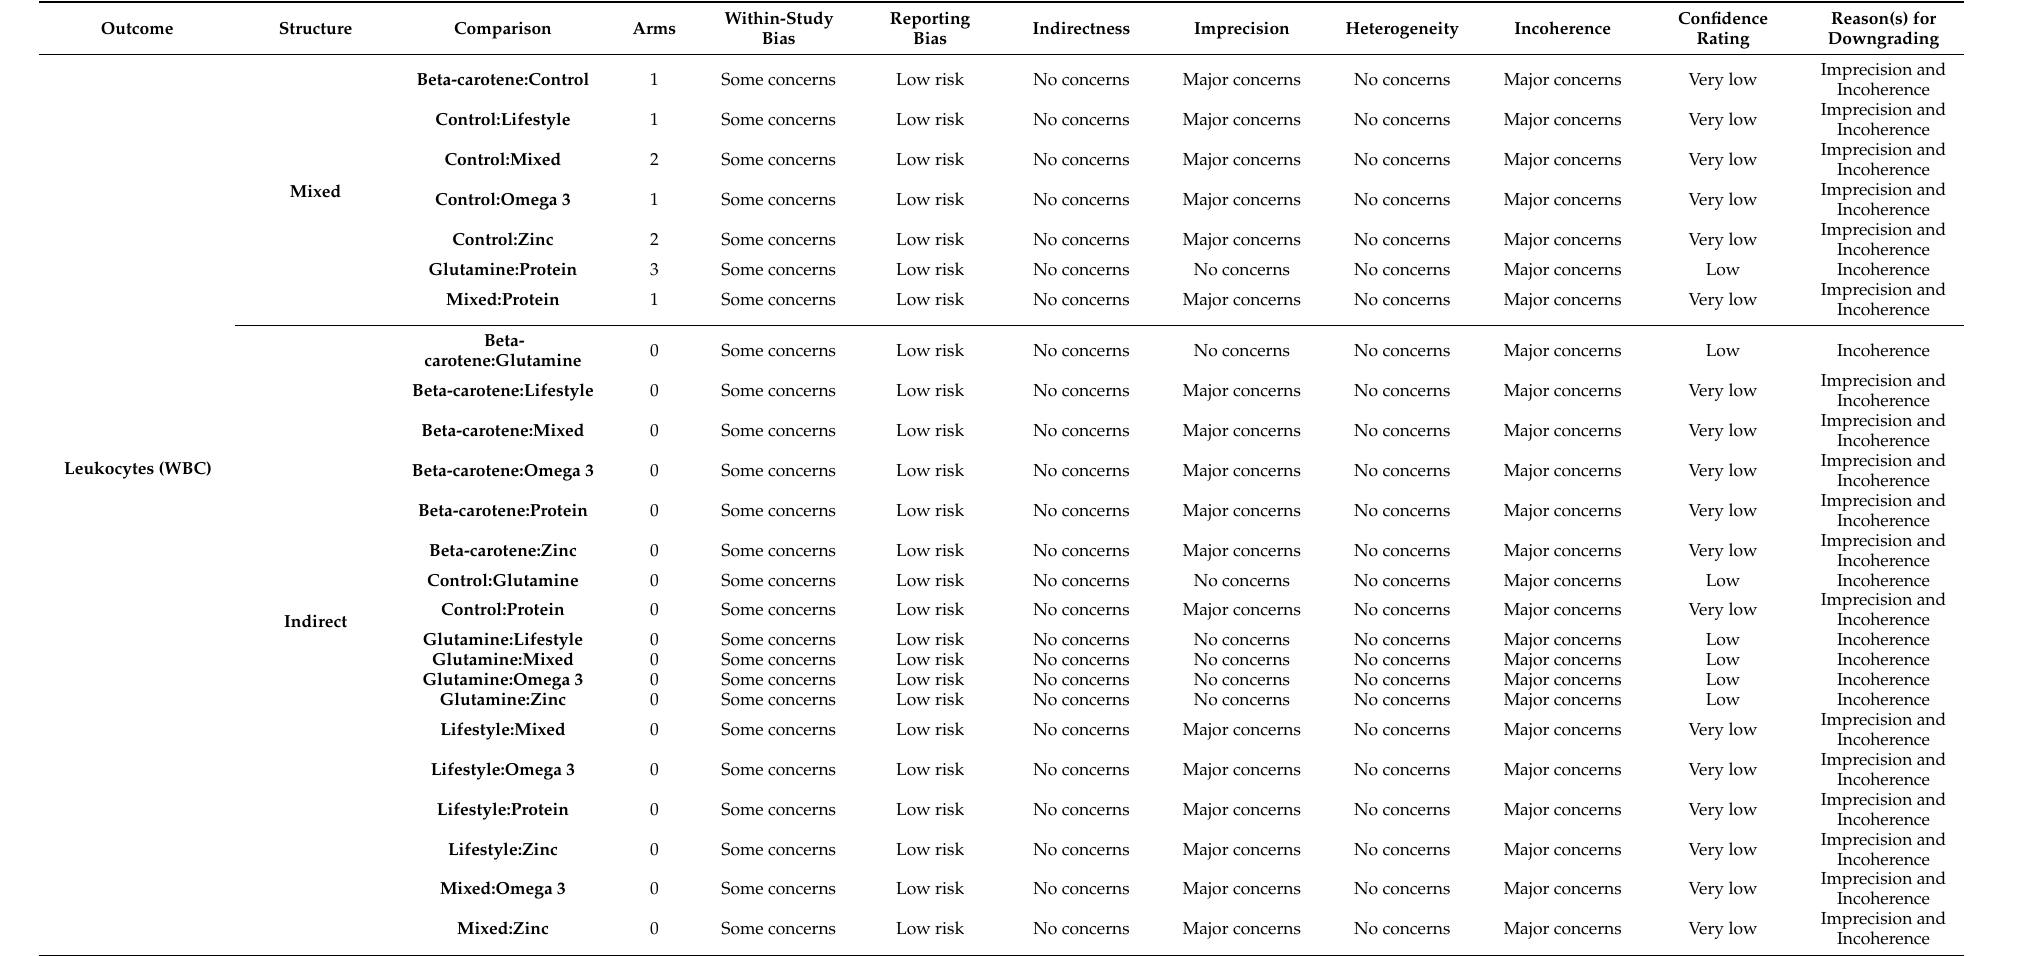
Table 6. Results of the confidence